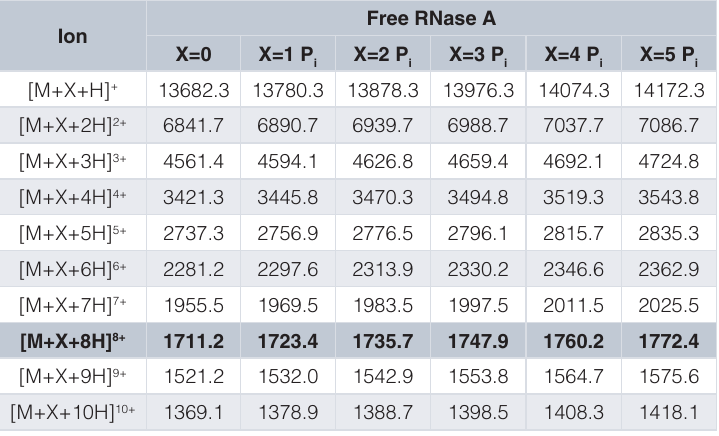
Table 2. Predicted m/z values for free RNase A with P charge state used in this work is